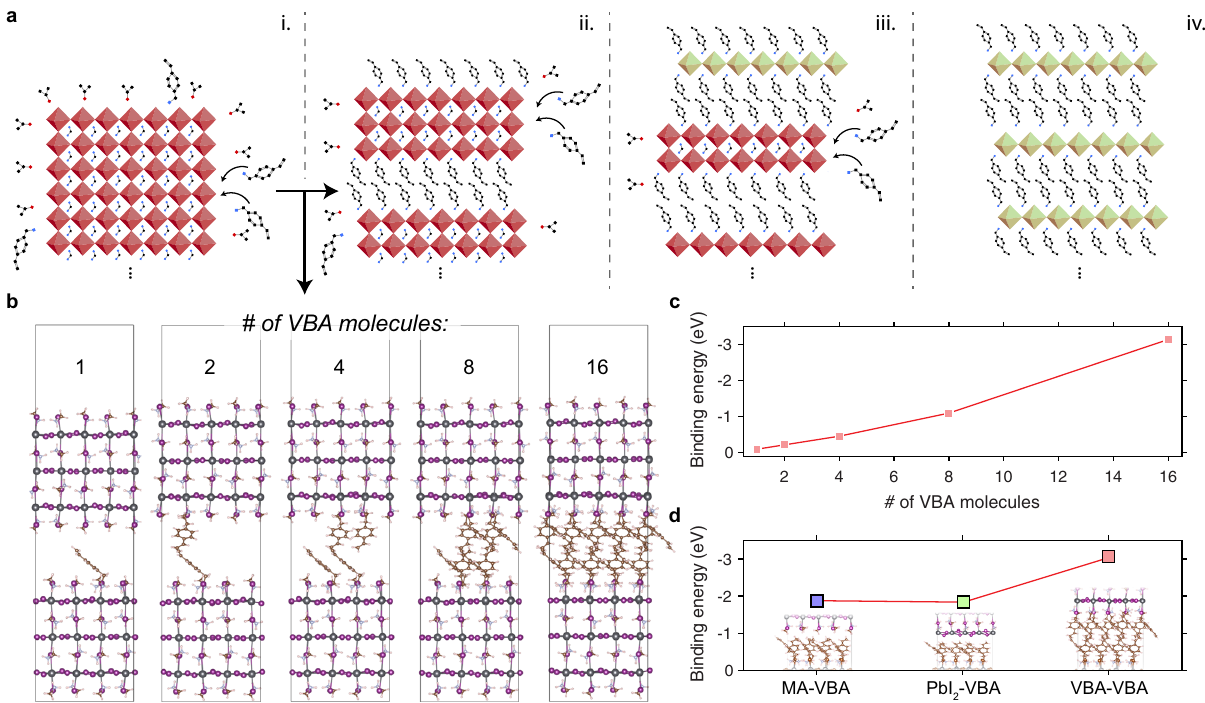
Fig. 4 Proposed 3D-to-2D conversion mechanism and DFT simulations. a Hypothesized transformation of a 3D perovskite surface into RDPs via (i) an initial in fi ltration of ligands and bisection of the lattice, (ii) formation of an n = 3 RDP and further bisection, (iii) formation of n = 2 and 1 RDPs, and (iv) fi nal reduced-dimensional form of n = 1. b Models used in DFT calculations to calculate binding energy of adjacent fragments, where the number of VBA molecules that substitute MA molecules on the surface are indicated above each structure. c Binding energy versus number of VBA molecules and d binding energies at 2D/3D interfaces formed by a VBA-terminated n = 1 fragment sandwiched between 3D fragments terminated by MA (blue), PbI 2 (green), and VBA